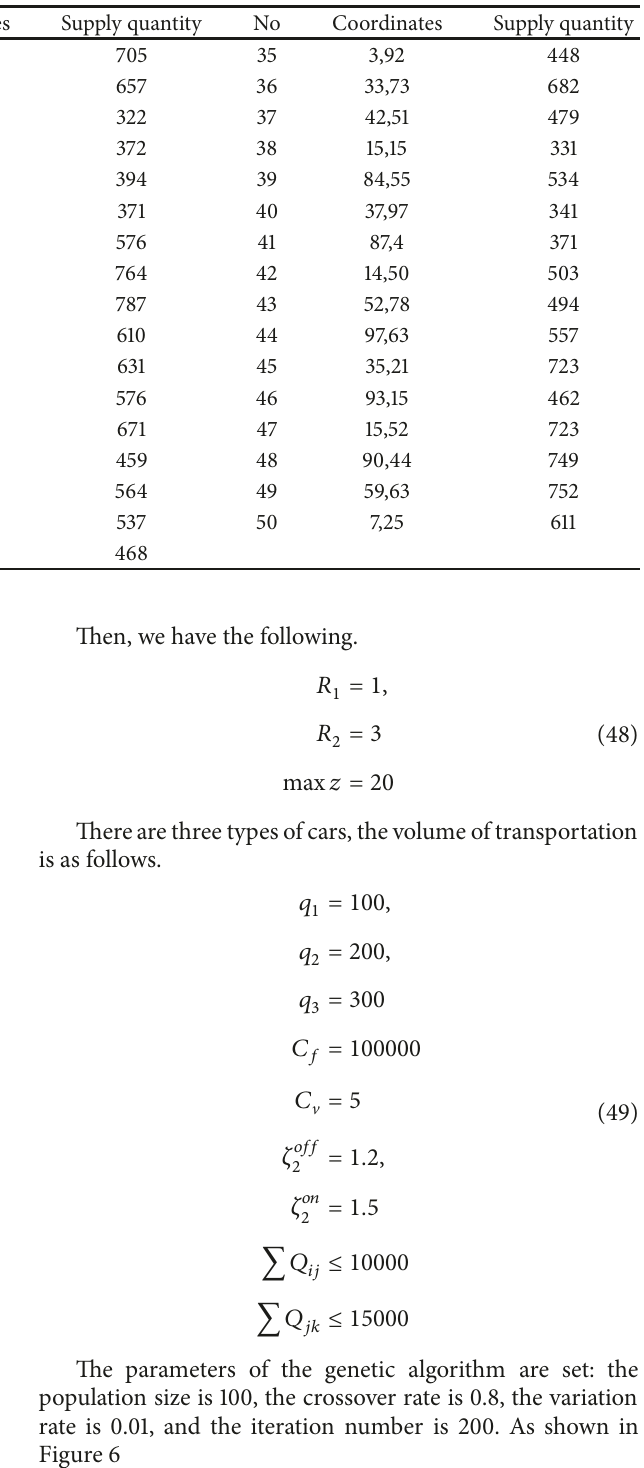
Table 5: Coordinates and quantity of suppliers for raw